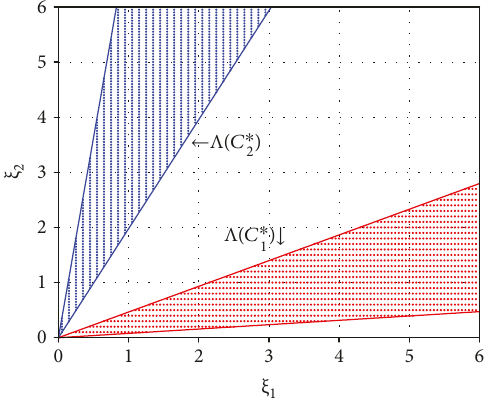
Figure 6: Λ C ∗ of the considered SNNs for Example 2. k